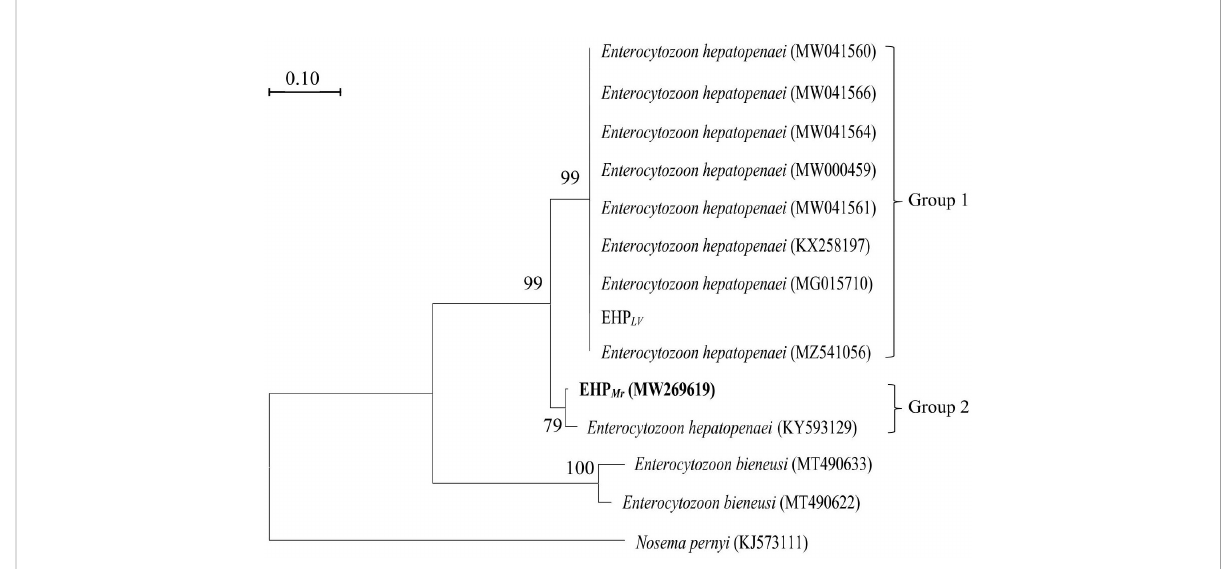
FIGURE 3 Phylogenetic tree of SWP1 gene of EHP isolates with other microsporidia. Nosema pernyi is used as the outgroup. Bootstrap values are indicated on the branches.